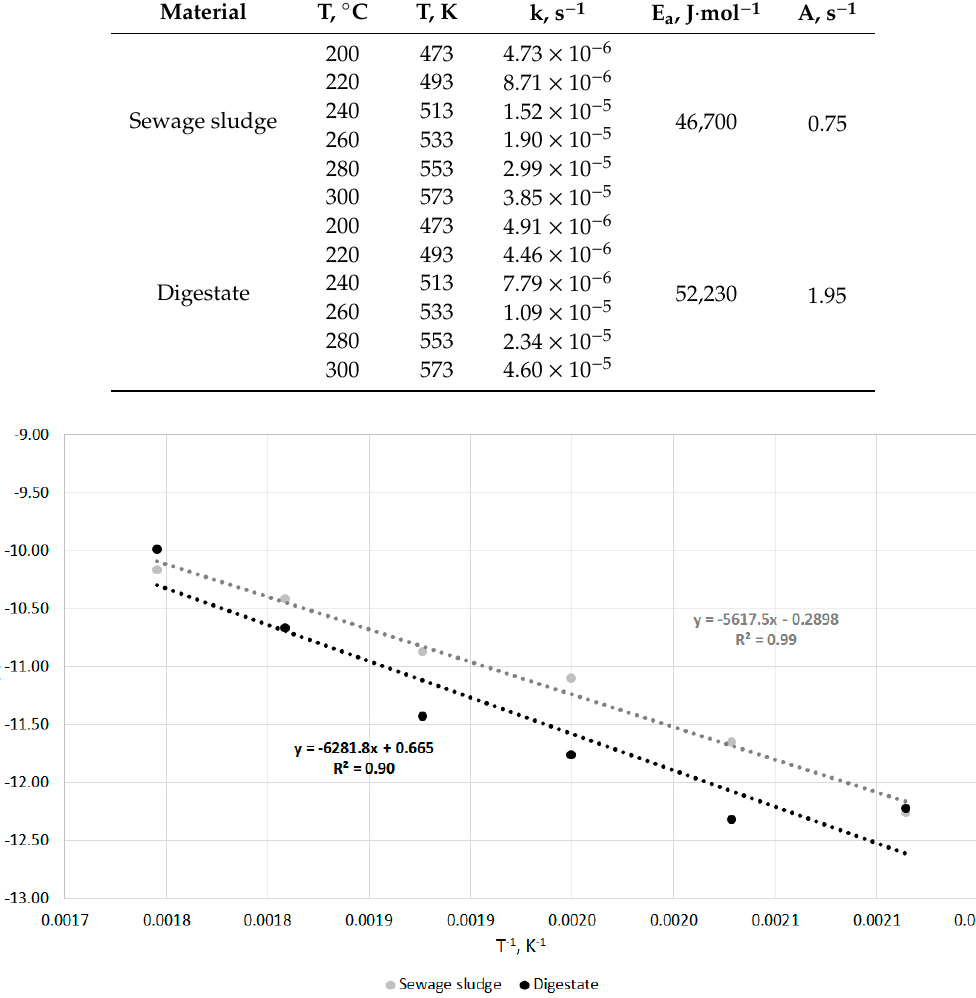
Figure 13. Arrhenius plot for sewage sludge and digestate.